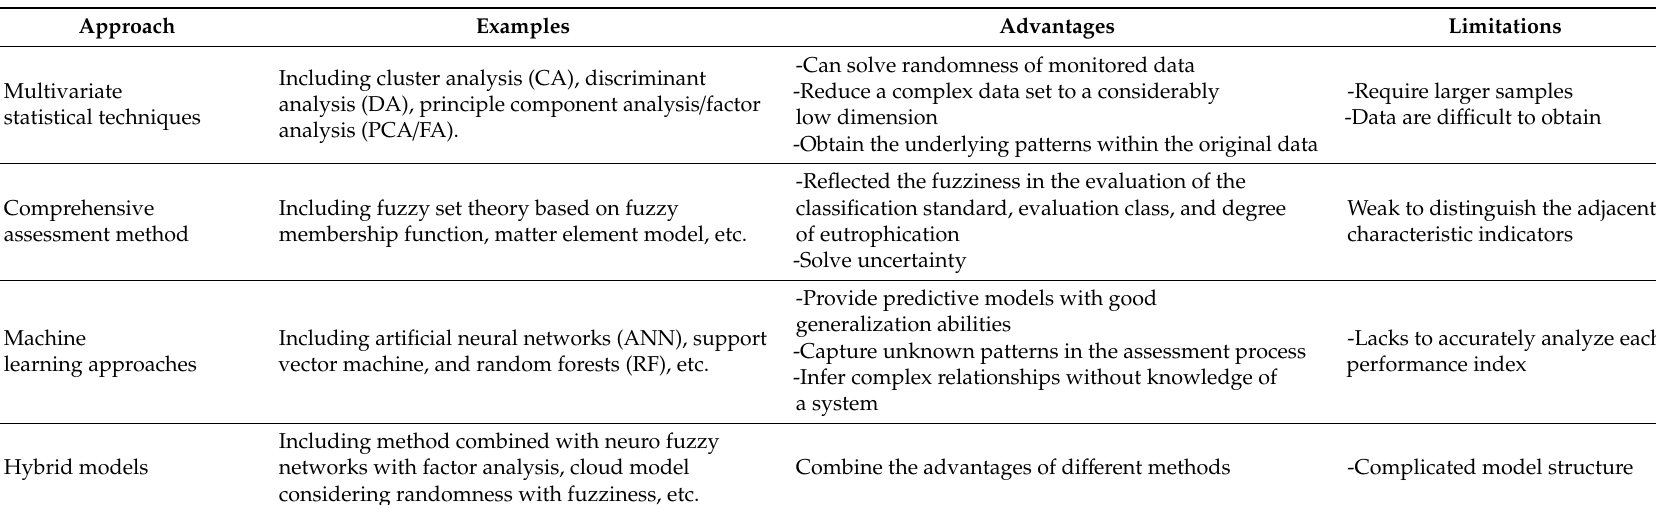
Table 1. Comparison of eutrophication evaluation